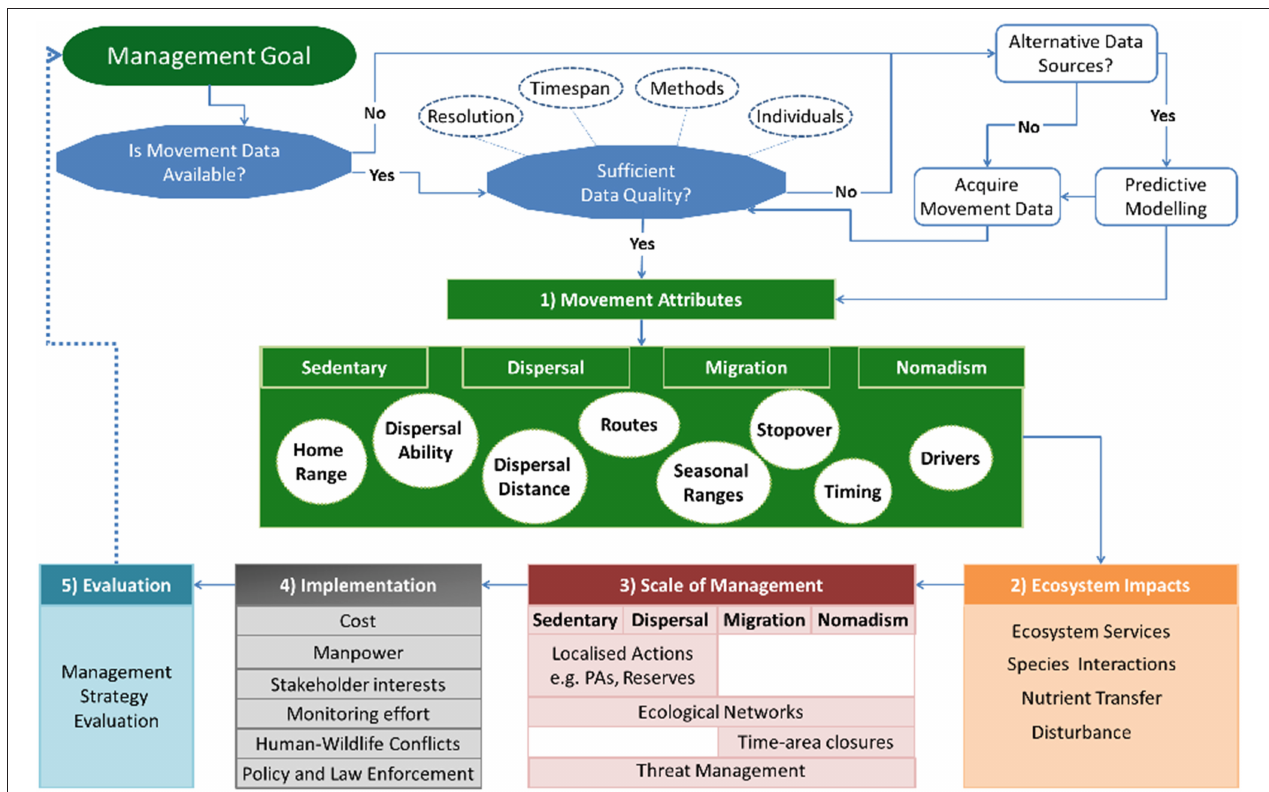
FIGURE 1 | Movement-management framework. Movement-Management framework that provides a workflow for incorporating movement ecology into decision-making processes. Before applying the framework, one must consider the quality of the movement data and whether it is appropriate for achieving the management goal. This includes questions like resolution, sample size, and the type of methods that will be used. Data may also be available from alternative sources, such as expert opinion or presence data, which can be combined with predictive modeling. Once appropriate movement data is available, the first step of the framework concerns understanding the movement attributes occurring in a study population or system. This includes the movement types that exist in a population that include “migration,” “dispersal,” “sedentary,” and “nomadism.” It is important to understand the characteristics of these movements, for example, movement pathways, home ranging patterns, or the timing of movements. The second step is to determine the ecosystem impacts and services resulting from movements. The knowledge gained from the first two steps guides the decision making process and identifies potential management actions that complement existing management plans. These may include actions that are flexible in space and time, such as time-area closures, which require detailed knowledge of species movements. The fourth step considers the implementation of the proposed actions, including considerations like available knowledge, cost, stakeholder interests and how these influence the effectiveness and feasibility of proposed actions. The final step evaluates the effectiveness of management actions, thereby creating an adaptive management cyclical process whereby the outcomes of the evaluation guide management objectives and future